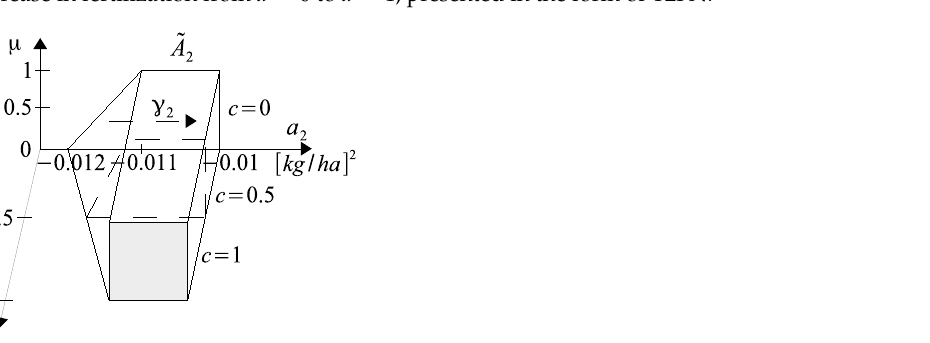
Figure 34. Knowledge of the value of the a 2 [ kg/ha ] 2 coefficient of inhibition of yield increase caused by fertilization, expressed in the form of T2FN.